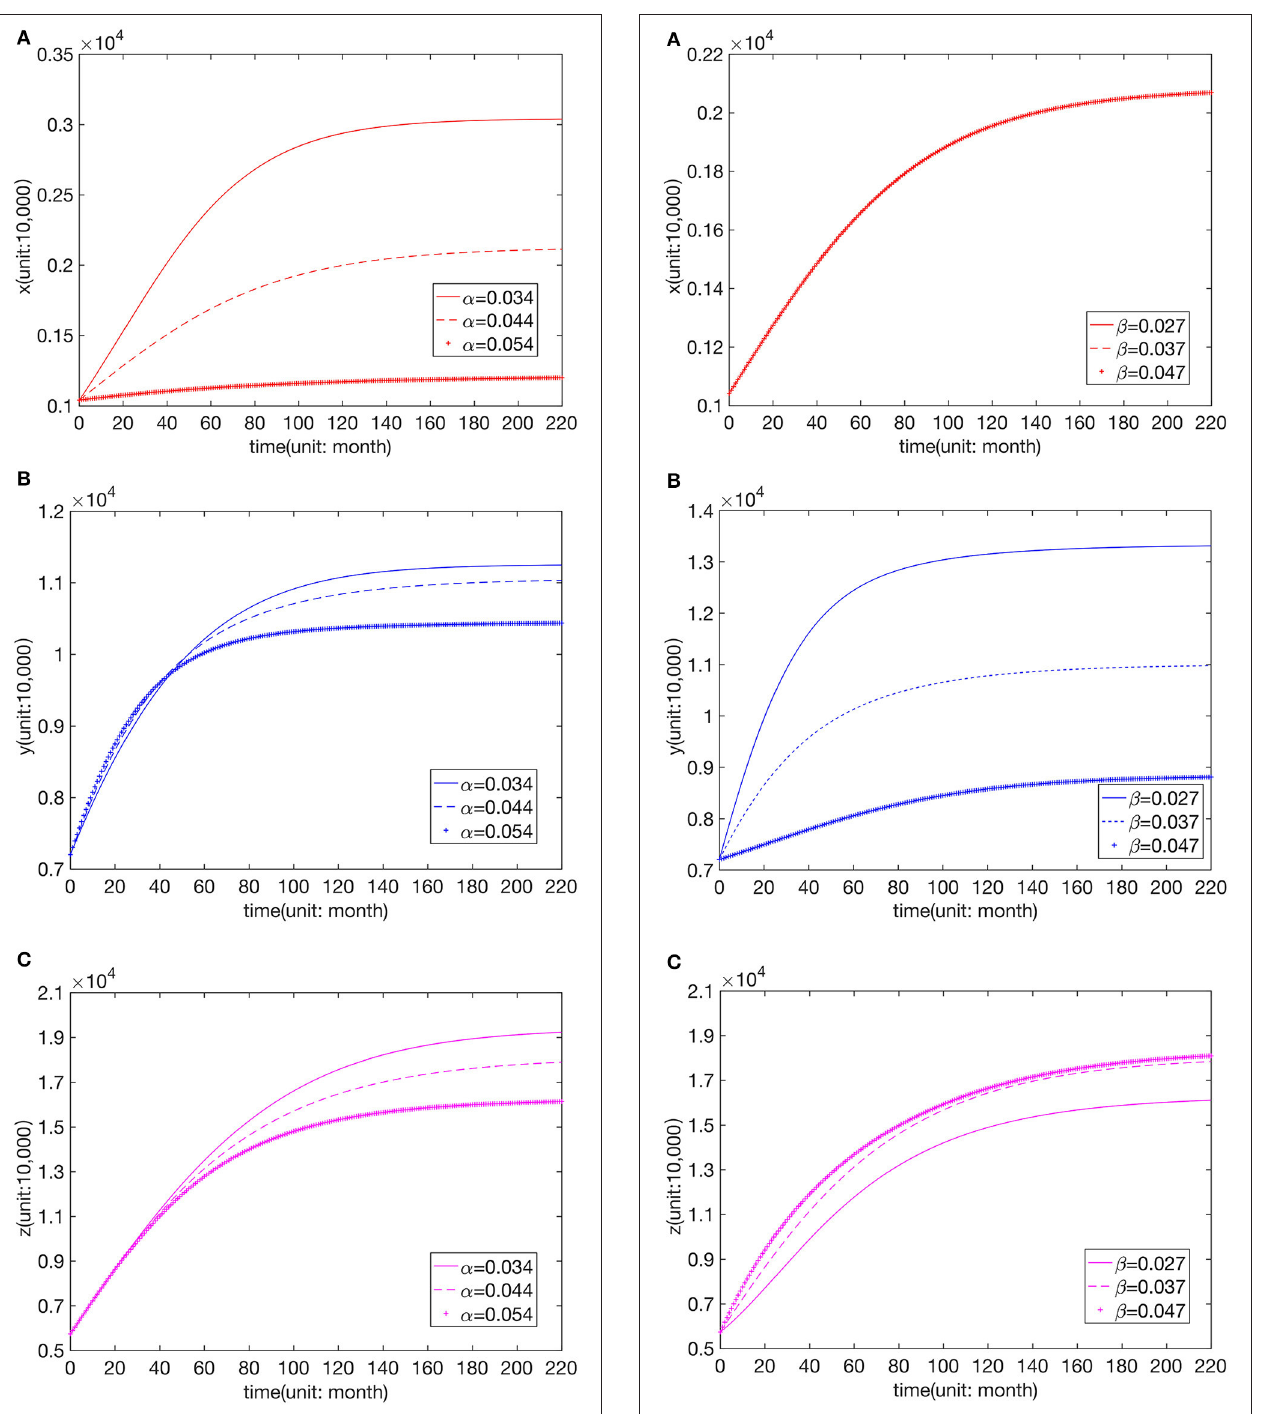
but when β is less than the fitted value, z decreases with the reduction in β .